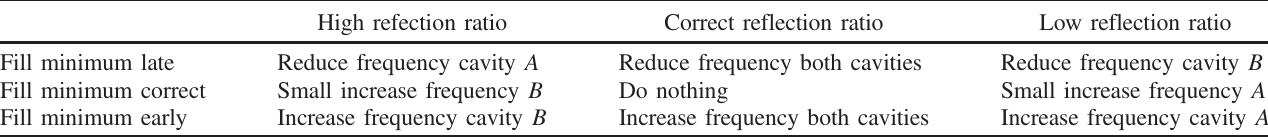
TABLE II. Fuzzy logic tuning algorithm for pulse compressor cavities at XBOX-1.